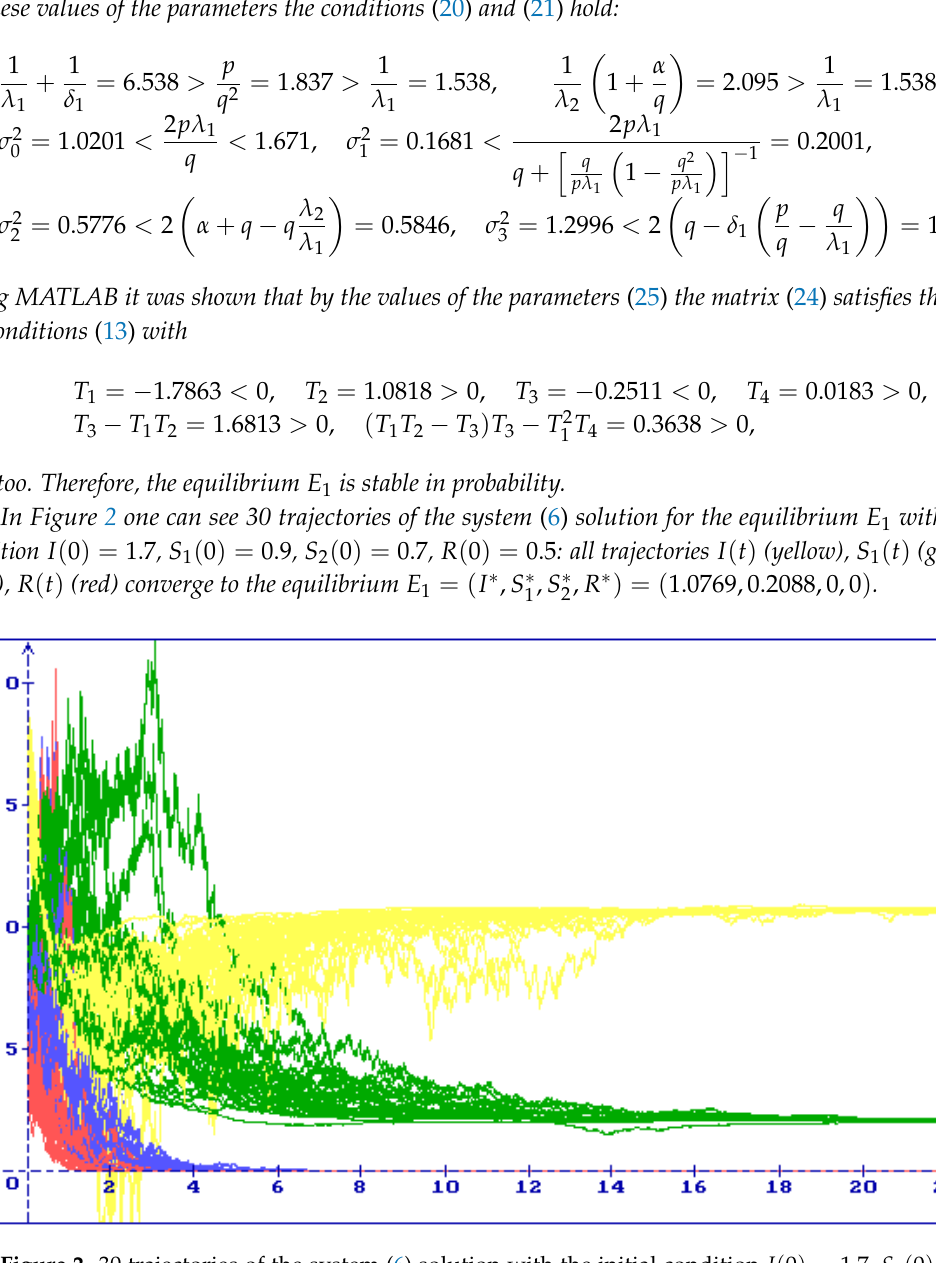
Figure 2. 30 trajectories of the system (6) solution with the initial condition I ( 0 ) = 1.7, S 1 ( 0 ) = 0.9, S 2 ( 0 ) = 0.7, R ( 0 ) = 0.5: all trajectories I ( t ) (yellow), S 1 ( t ) (green), S 2 ( t ) (blue), R ( t ) (red) converge to the equilibrium E 1 = ( I ∗ , S ∗ , S ∗ , R ∗ ) = ( 1.0769,0.2088,0,0 ) 2 1